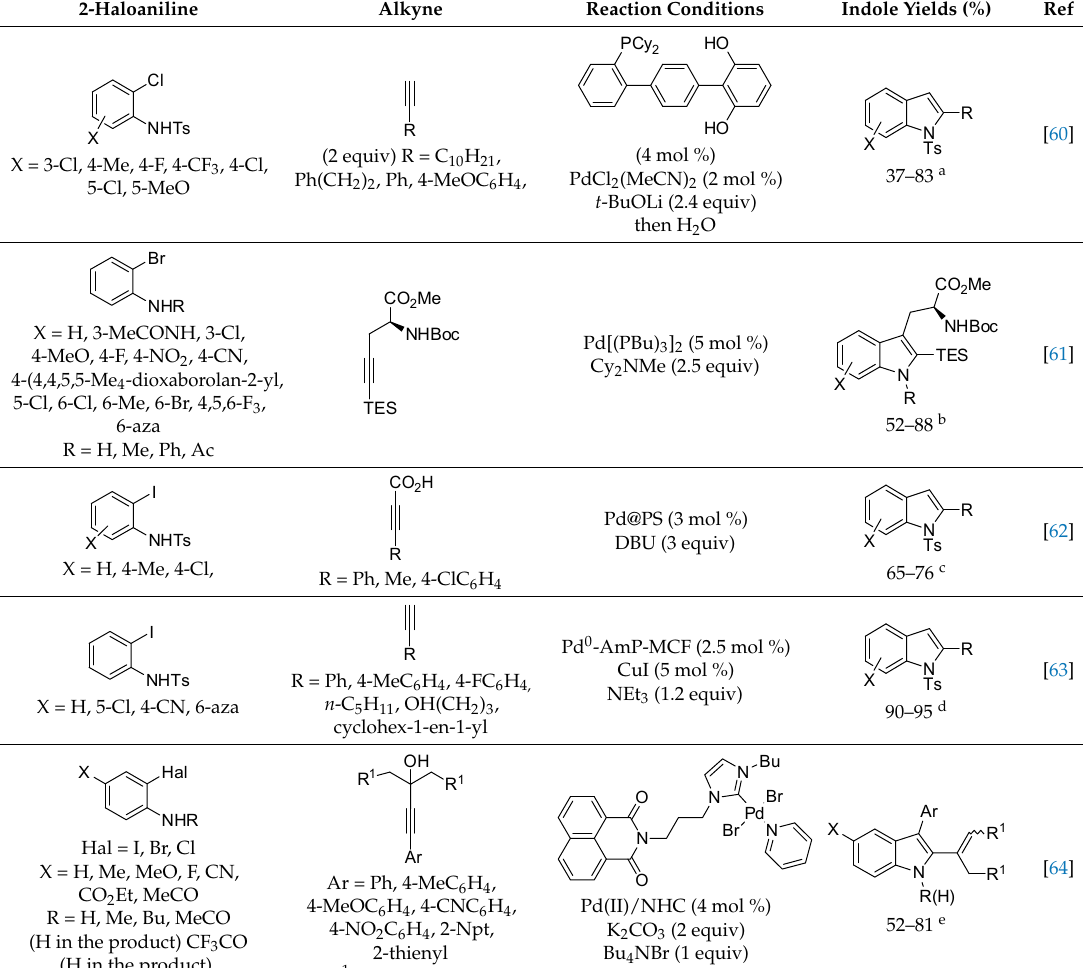
Table 1. Palladium catalyzed reactions of 2-haloanilines with alkynes to give indoles. 2-Haloaniline Alkyne Reaction Conditions Indole Yields (%) Ref Cl X = 3-Cl, 4-Me, 4-F, 4-CF 3 ,